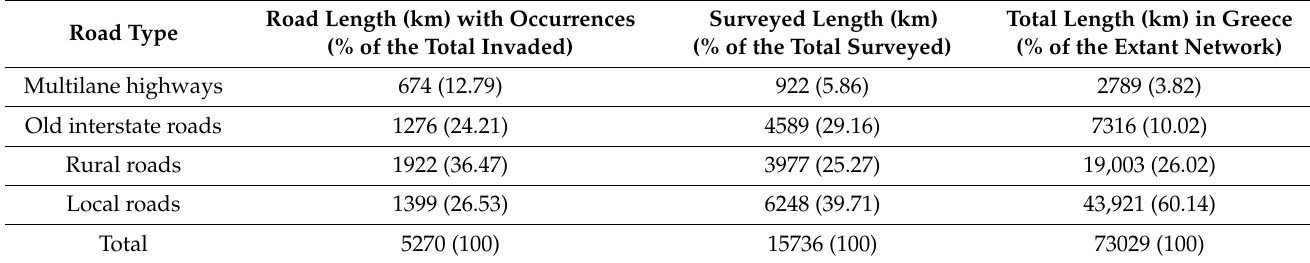
Table 2. Length of different road types surveyed in Greece for noninvaded and invaded areas by Solanum elaeagnifolium . Road Type